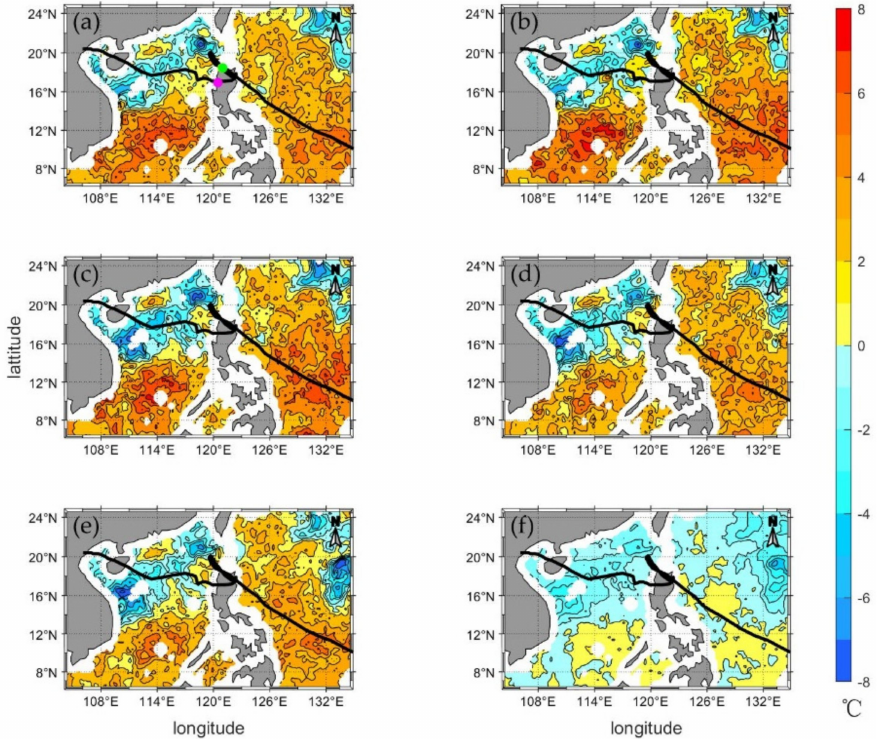
Figure 12. Track of Typhoon Parma and temperature change after its transit in 2009: ( a ) Describes the change of SSTA on the first day after the typhoon. The green dot represents the typhoon center at 18:00 on 3 October and 18:00 on the 6th; the magenta dot represents the typhoon center at 18:00 on 8 October; ( b–f ) Describes the changes in SSTA 2–6 days after the typhoon.